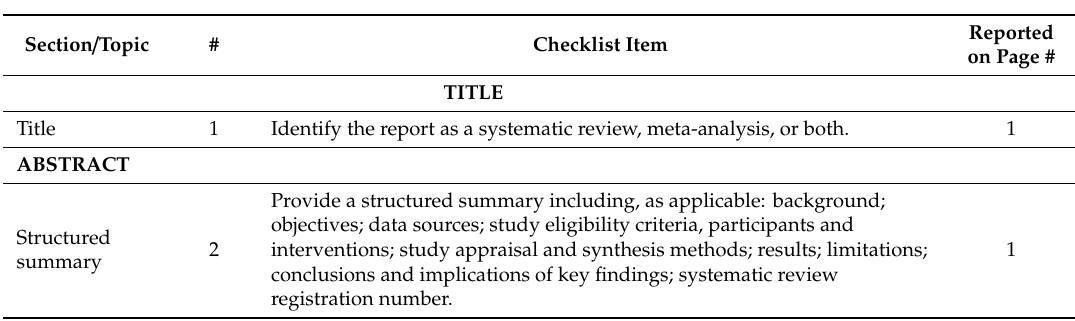
Table A1. PRISMA